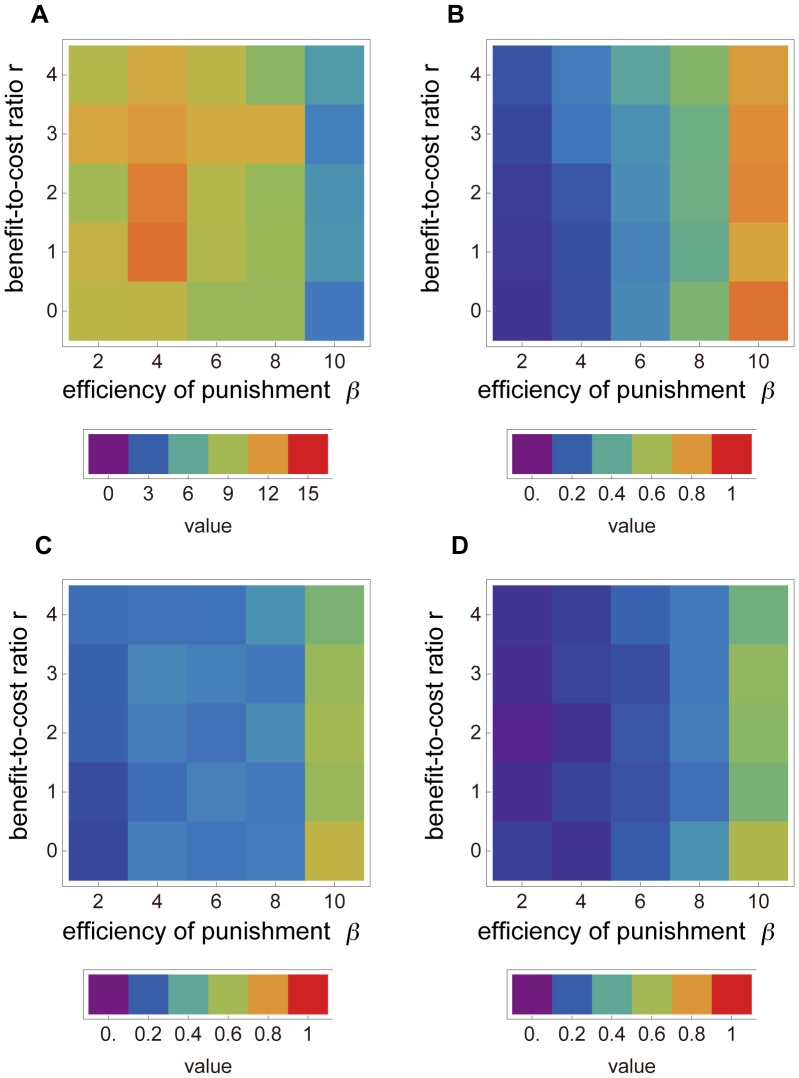
Effects of parameters on evolution in the random-matching condition.The horizontal and vertical axes represent the effectiveness of public goods (r) and punishment (β). (A), (B), (C), and (D) represent the average values of a (strictness), x (cooperation level), f (punishment level), and u (punishment threshold) at 1,000,000 generations, respectively. Deeper color means the trait evolved to a higher value. Each data block is the average of 50 trials. Each bar below each graph presents the relationship between a value and color.